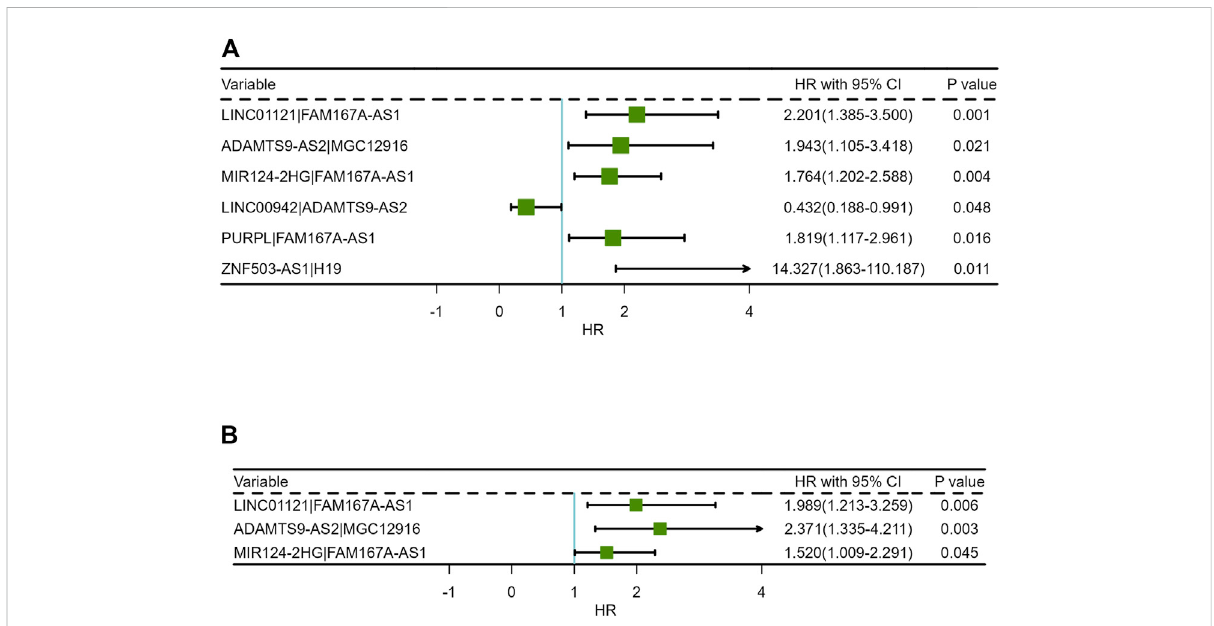
FIGURE 3 Forest plots of Cox regression analysis for ir-lncRNA pairs: (A) Univariate Cox regression analysis, (B) Multivariate Cox regression